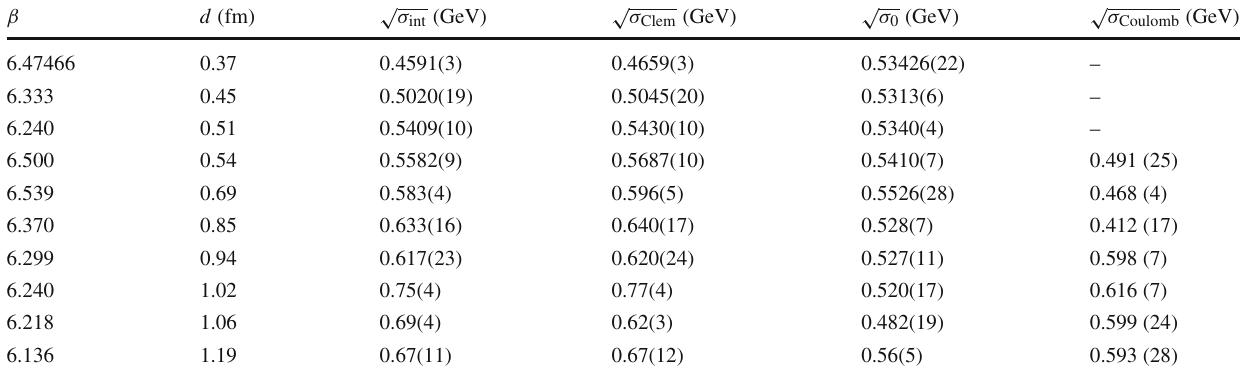
Table 4 The string tension estimated using the non-perturbative field from the curl procedure by employing different methods (from left to right: numerical integration of the field, analytical integration of the Clem function with parameters given in Table 3, estimation of fields